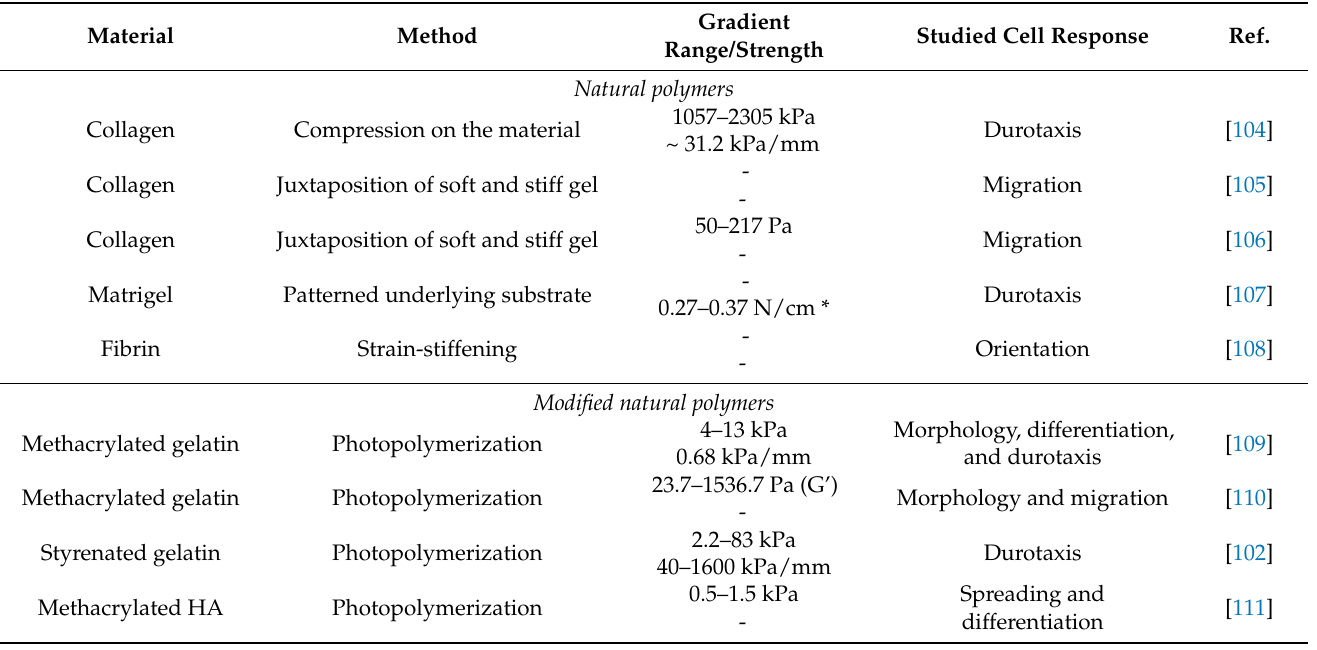
Table 2. Examples of creating stiffness gradient in a hydrogel for cell studies (stiffness values listed are Young’s modulus, unless stated